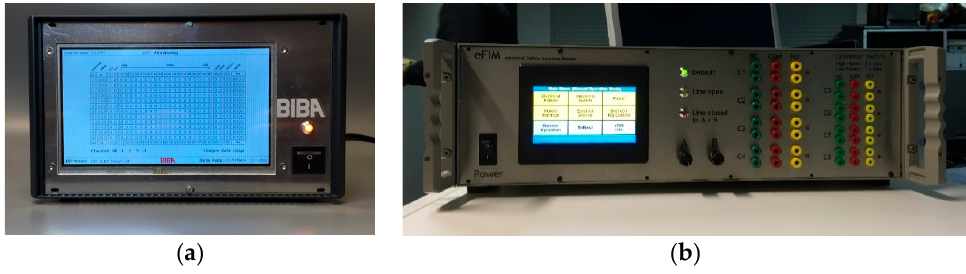
Figure 16. EtherCAT based- ( a ) ARINC 429 ( b ) electrical failure injection I/O.